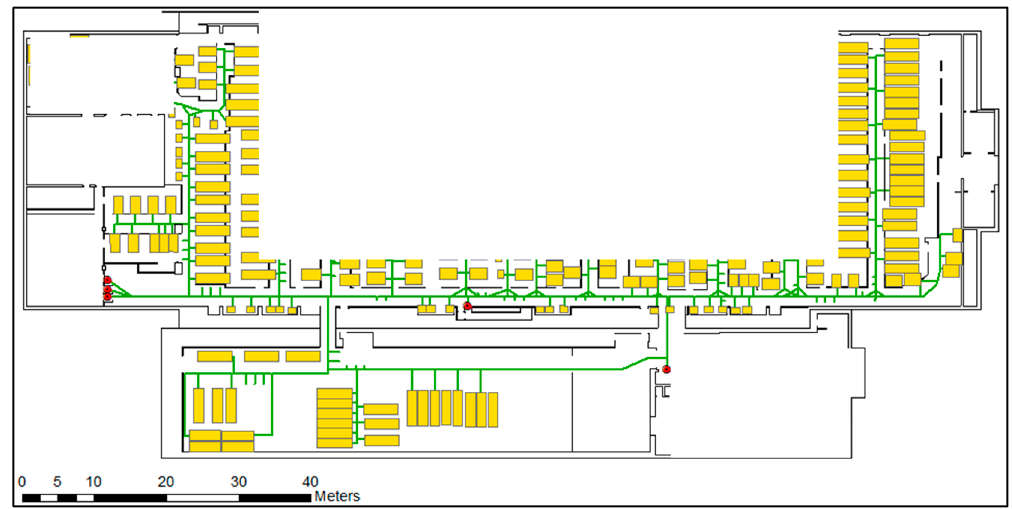
Figure 4. An indoor space layout of the manufacturing environment. Yellow rectangles represent devices in the clean room, and red dots represent transfer nodes. The green lines represent the traversable indoor network. The white spaces intentionally disguise the complete production layout (adapted from [10]).